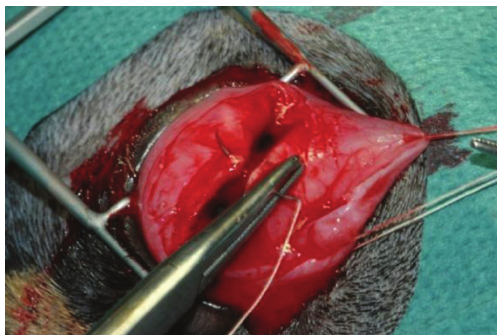
Figure 2: Four-and-a-half-month-old Bernese mountain dog with end-stage, glaucomatous left eye seven weeks after cat claw injury.